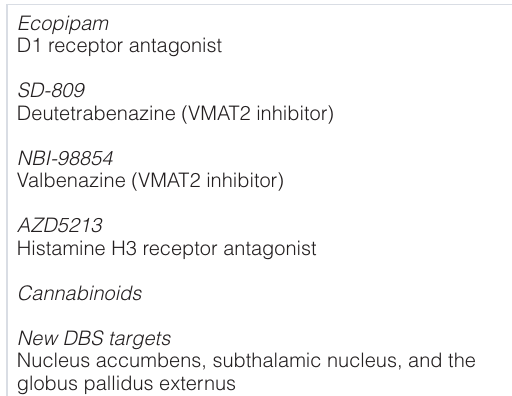
Table 2. Emerging Therapies for Tourette